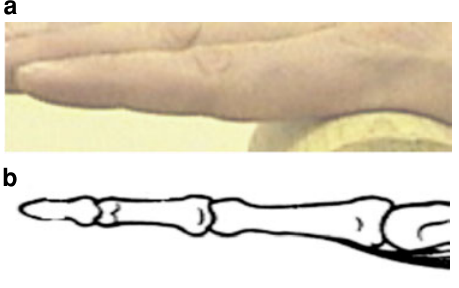
Figure 9 A human index finger as design reference for a finger-driving mechanism: (a) a photo of the reference finger; and (b) index finger skeleton (Taylor and Schwartz 1955).